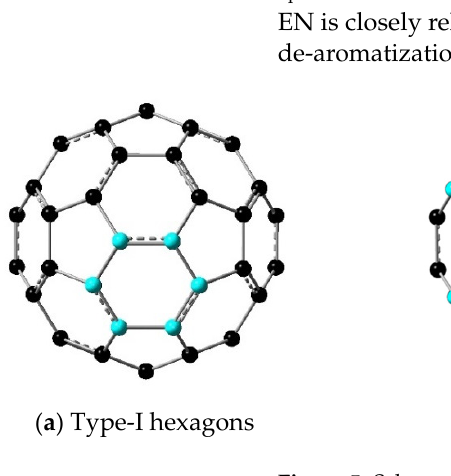
Figure 5. Schematic view of the three types of hexagons considered in the HOMA analysis (in blue): ( a ) regular hexagons in C 60 ; ( b ) and ( c ) adjacent hexagons to the addends in fullerene adducts, which, due to release of bond strain, become more aromatic. In the case of ( c ), they are simultaneously adjacent to two addends. Structures taken from the optimized M06-2X/6-31+G(d) geometries.